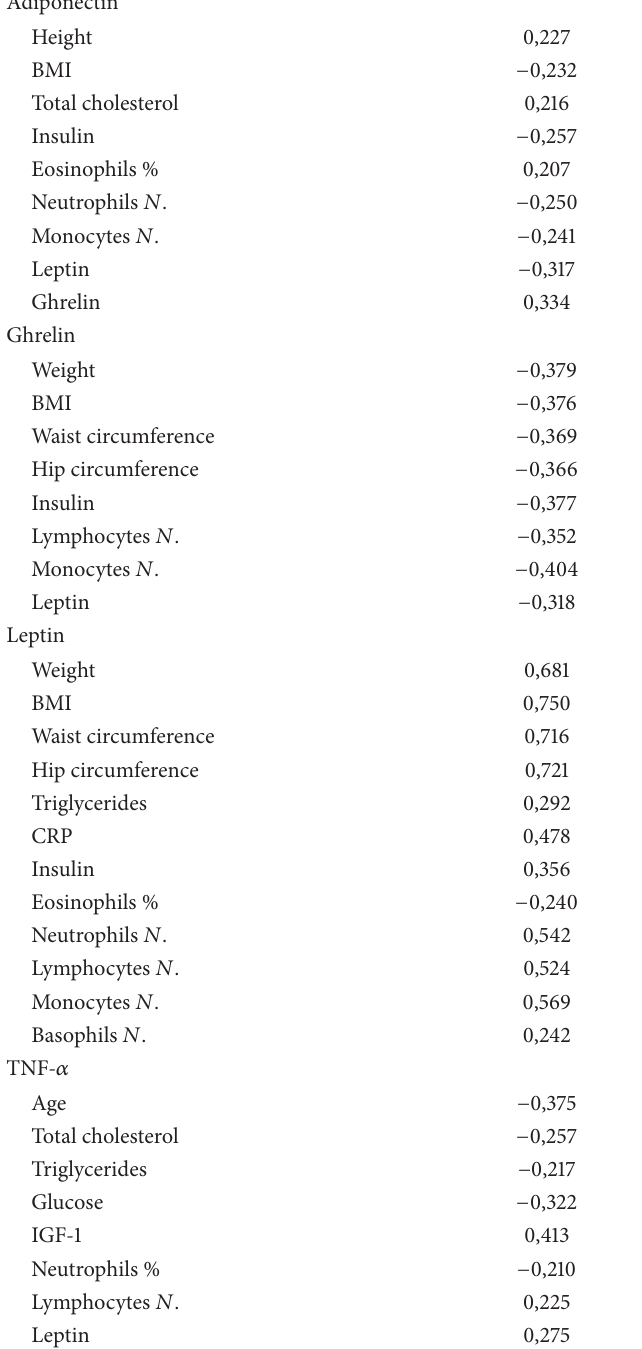
Table 2: Correlations of adipokines and ghrelin with all other parameters investigated in the study. Only significant correlations with the respective 𝑟 coefficient are reported ( 𝑃 < 0.05 ).